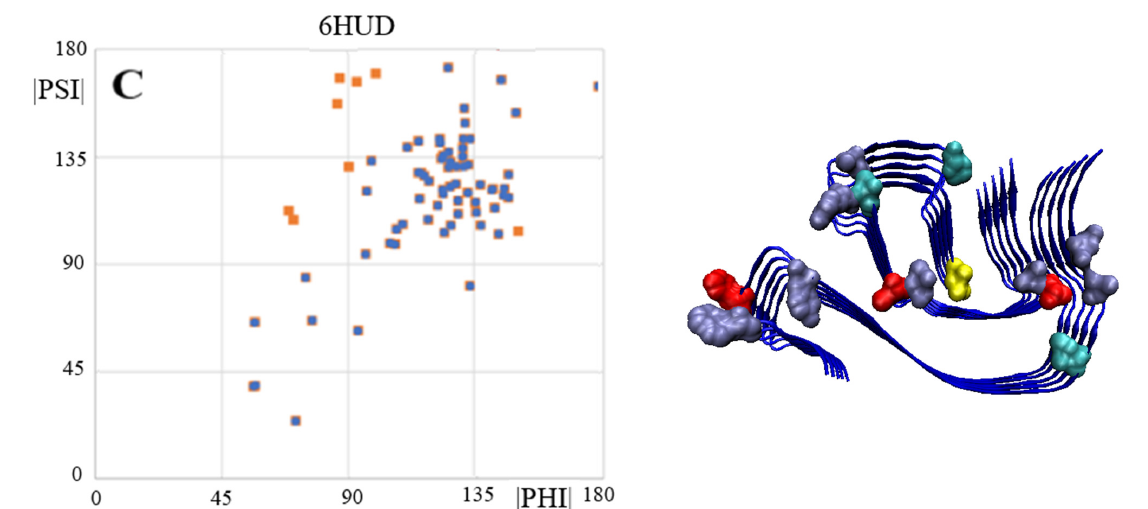
Figure 6. The 3D display of the fibril reveals the location of residues with a conformation deviating from the model at the starting or ending positions of segments with a linear β -structure form. ( A ) – the complete V domain of IgG. ( B )—part of domain V of the IgG light chain as present in amyloid form of this amyloid—highlighted in the 3D presentation as in point A. ( C )—amyloid form of domain V of IgG light chain ‐ amino acids highlighted in a 3D presentation as in Figure 5. * ‐ denotes the section of V domain present in the amyloid form.